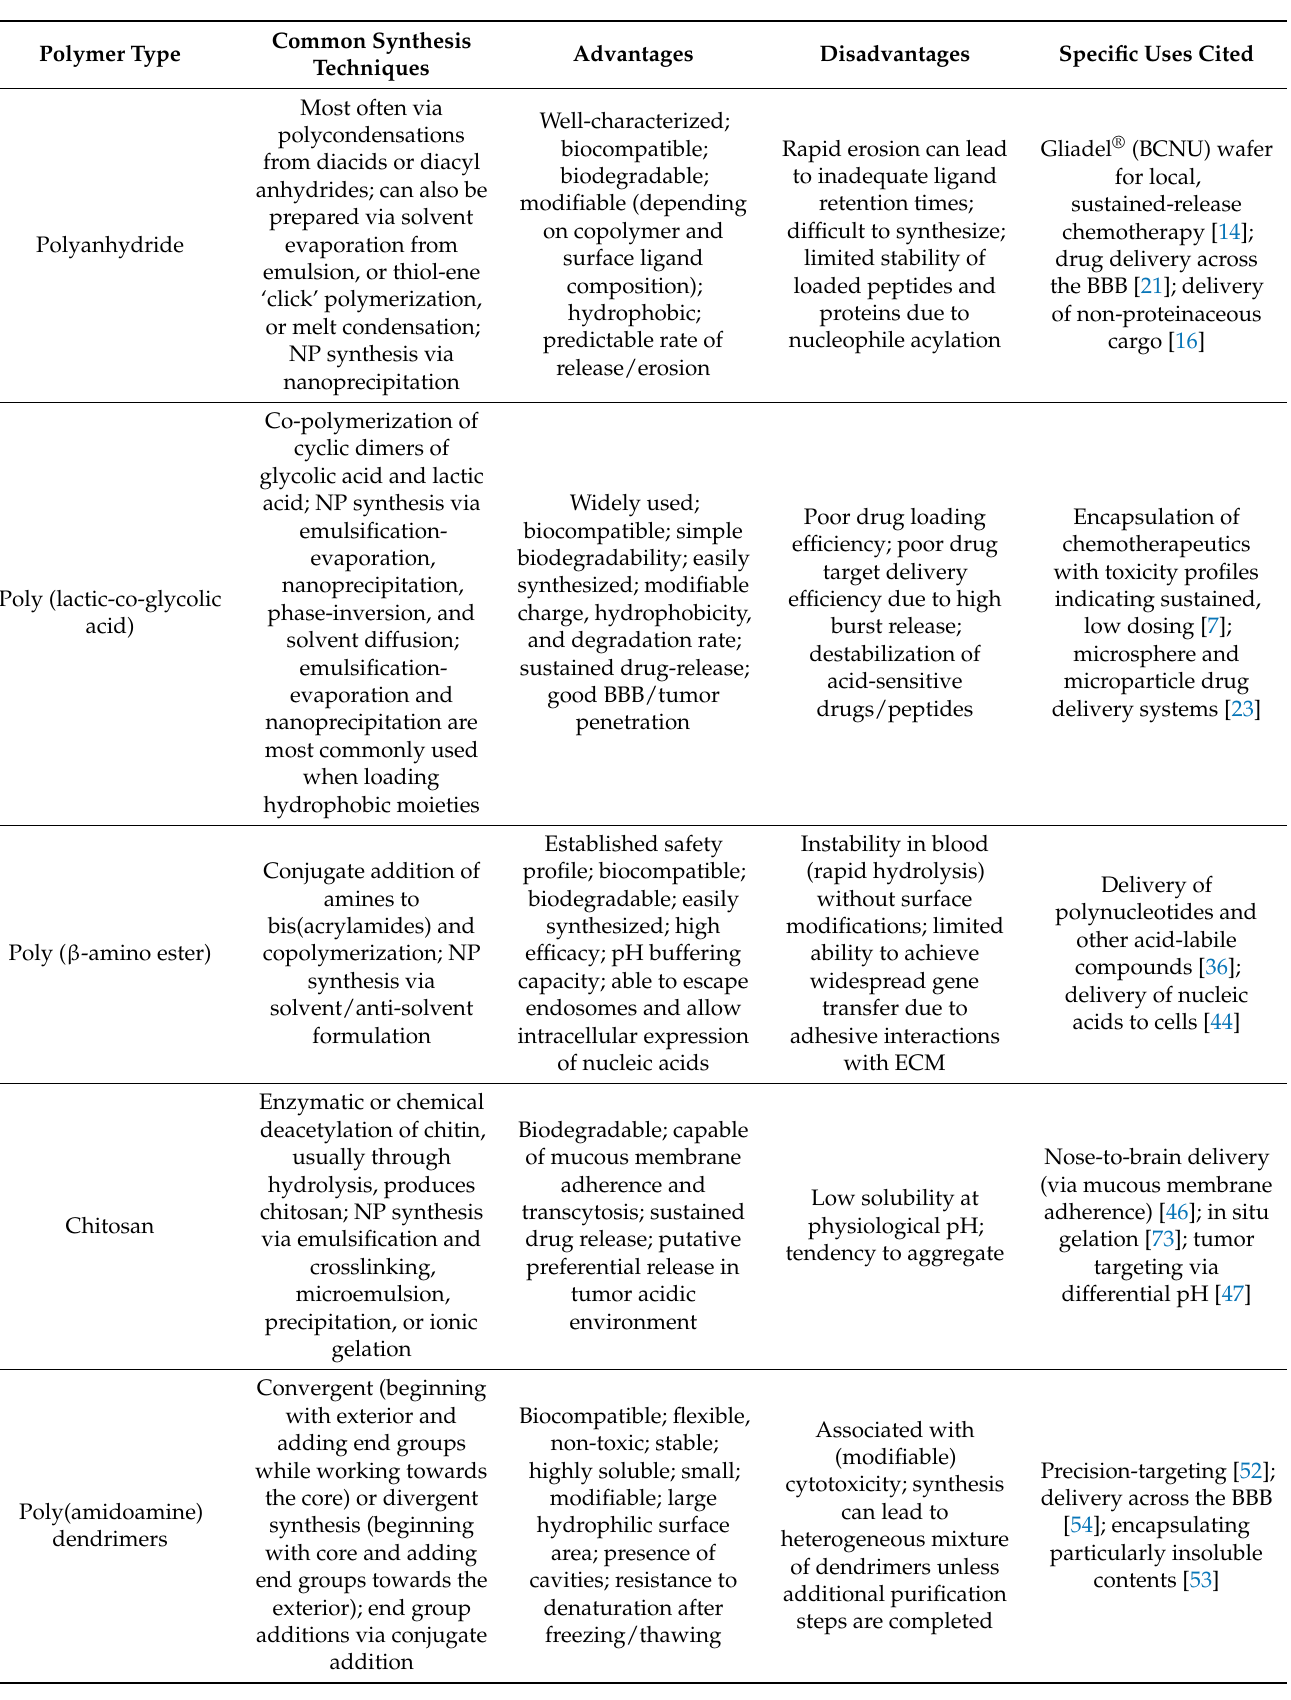
Table 1. Comparison of polymer subtypes and